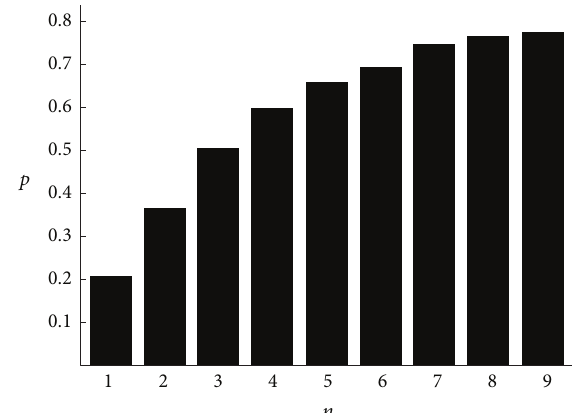
Figure 8: Statistical result between the different superposition times average results 𝑛 and the recognition accuracy 𝑝